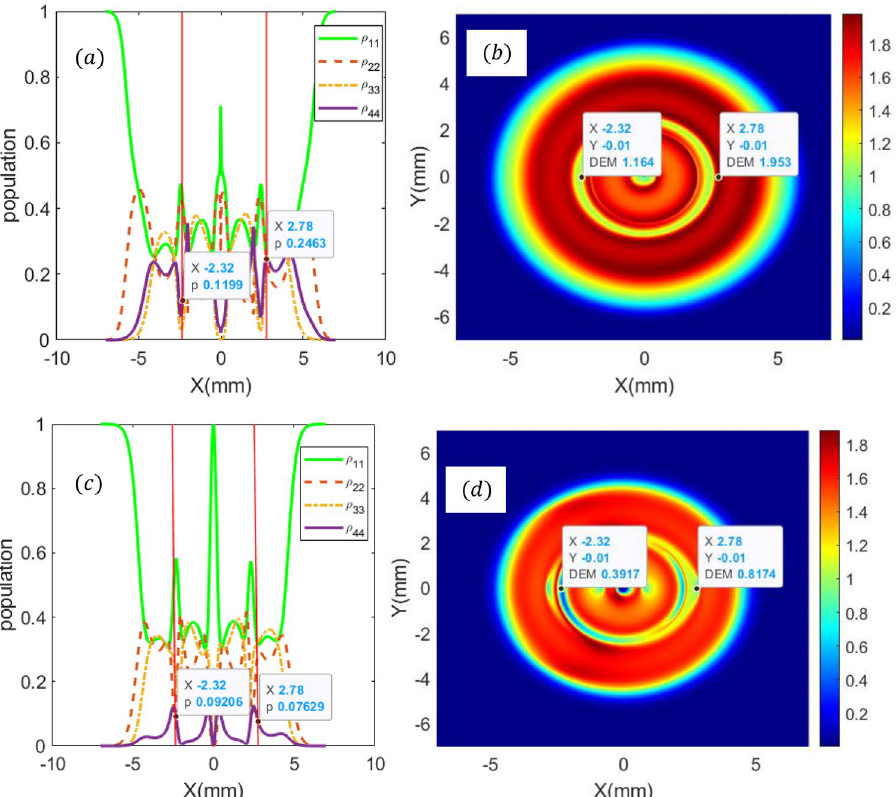
Figure 6. Steady-state population distribution as a function of x (y = 0) ( a , c ), and DEM density plots as a function of x and y ( b , d ) for T A Other parameters are l 2 δ = � 1 = � 2 = 0, and ω 43 = 0.6 γ